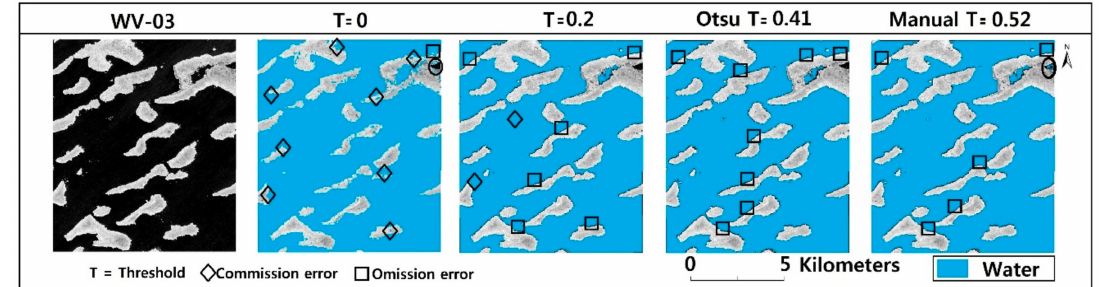
Figure 8. Water maps derived from different thresholds. Landsat date 12 December 2015. The circle represents an area of turbid water.